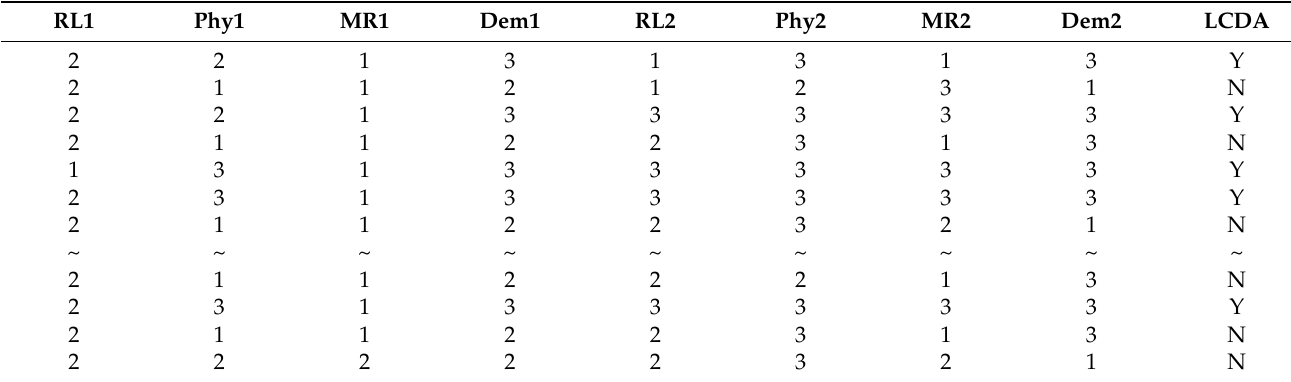
Table 8. LCDA Dataset of Older People.